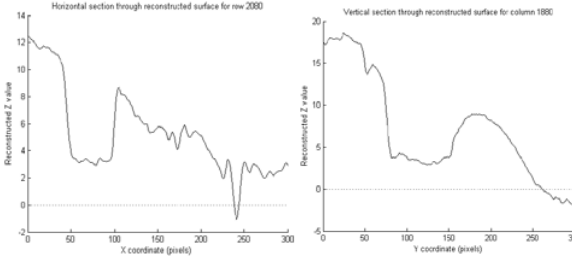
Figure 15. (left) Horizontal and (right) vertical cross-sections through the reconstructed surface.